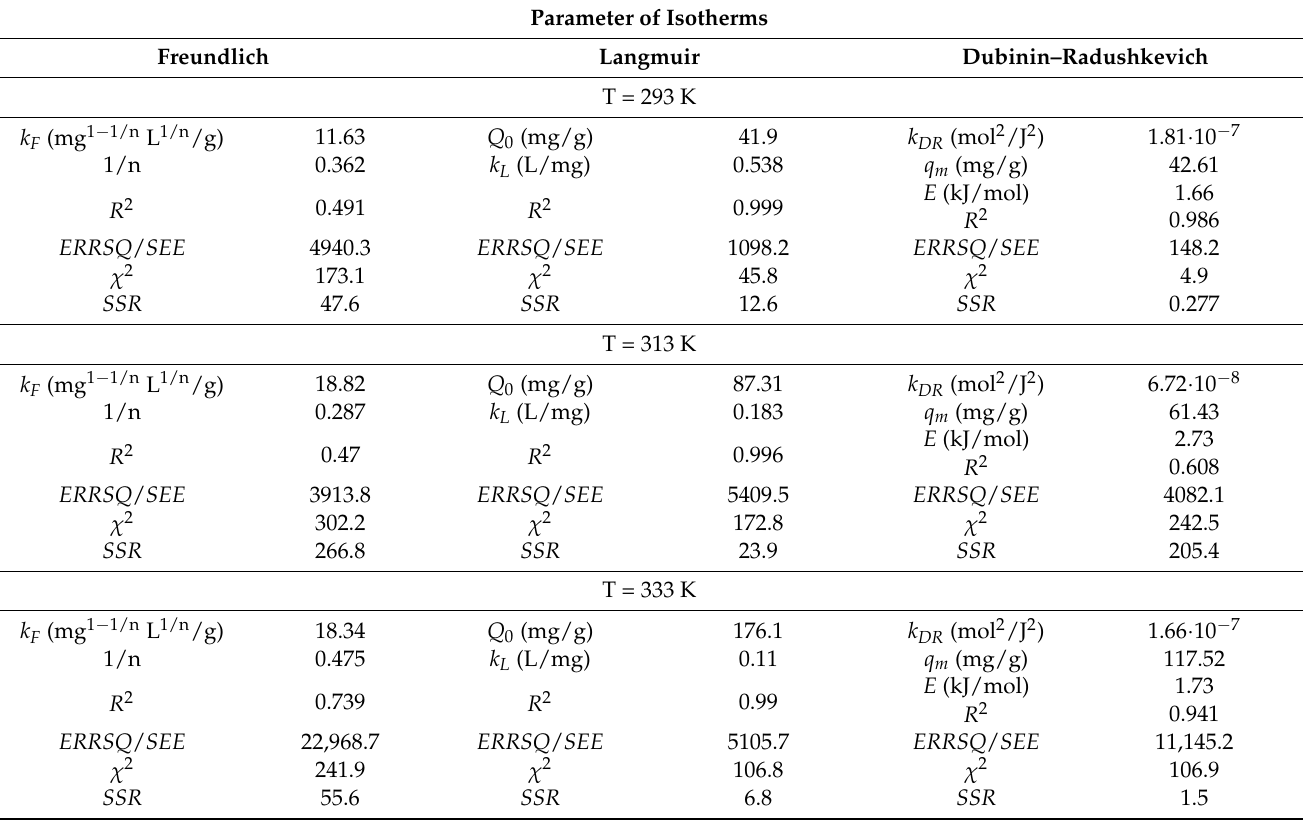
Table 1. Values of parameters of the Freundlich Langmuir, and Dubinin–Radushkevich isotherms calculated for BR46 adsorption on C/SiO 2 composite as a function of